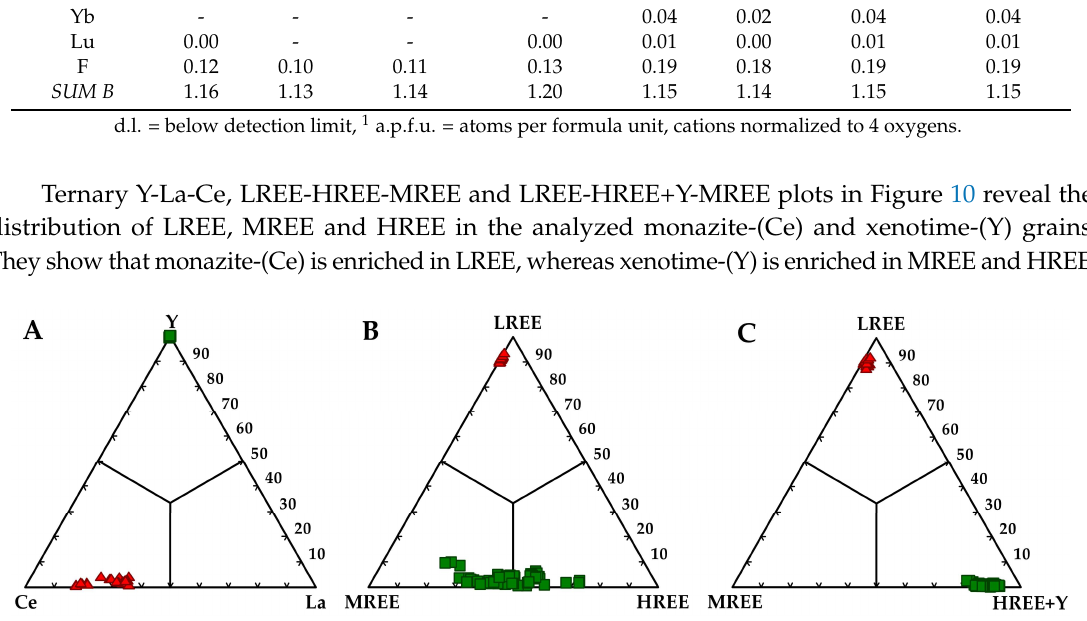
Figure 10. Ternary ( A ) Y-La-Ce, ( B ) LREE-HREE-MREE, ( C ) LREE-HREE+Y-MREE plots of the REE compositions of analyzed monazite (red triangles) and xenotime (green squares) grains in bauxitic samples of the CCR. Note that the REE composition in xenotime is considerably more varied than in monazite ( B ). LREE = ∑La-Pm, MREE = ∑Sm-Dy, HREE = ∑Ho-Lu.